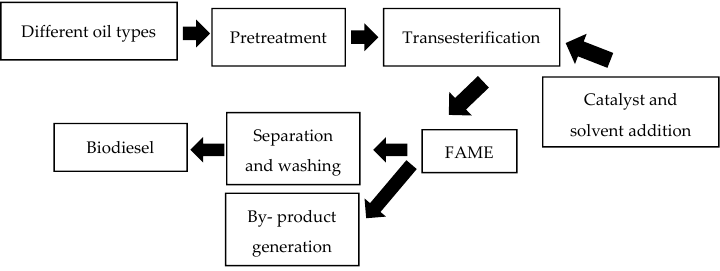
Figure 3. Biodiesel production via the transesterification process .